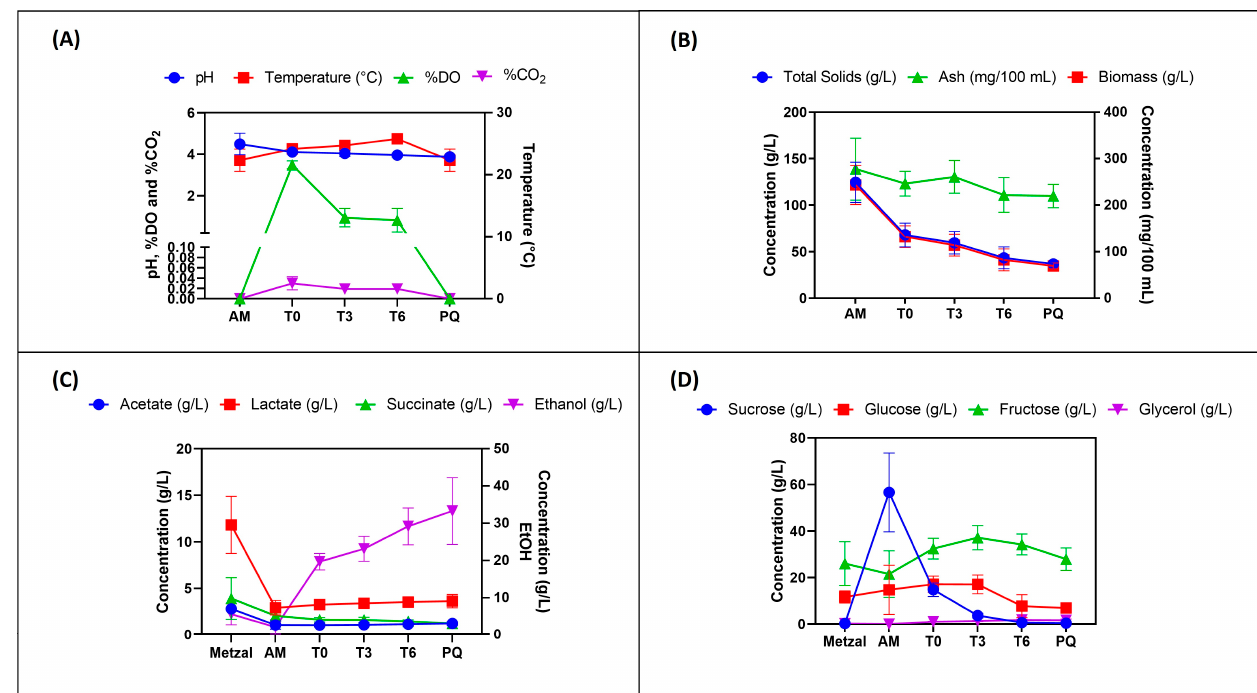
Figure 2. Metabolic characteristics and physical parameters of metzal, AM, and PQ fermentation. ( A ) Physical parameters. ( B ) Biomass, total solids, and ash content. ( C ) Organic acids and ethanol. ( D ) Carbohydrates. The graphs represent the average of the triplicates analyzed. Regarding total solids, biomass, and ashes, AM showed an average of 124.5 g/L of total solids, 121.81 g/L of biomass, and an ashes content of 277.7 mg/100 mL. After 6 h of